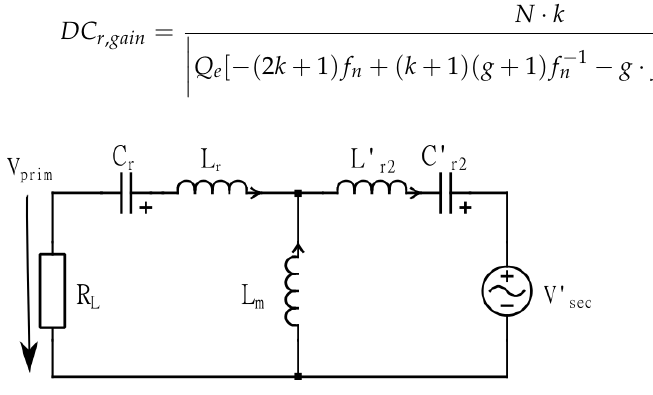
Figure 8. Simplified FHA model of CLLC in reverse